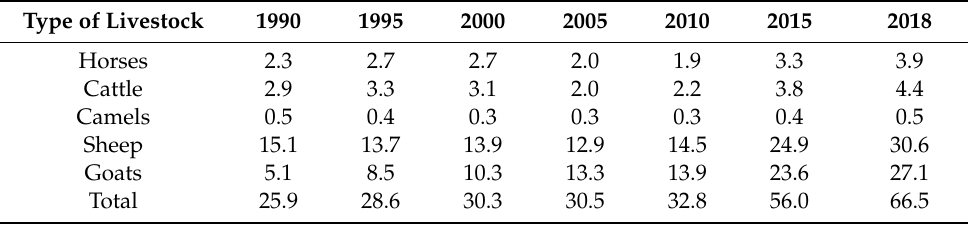
Table 1. Livestock population dynamics in Mongolia, million